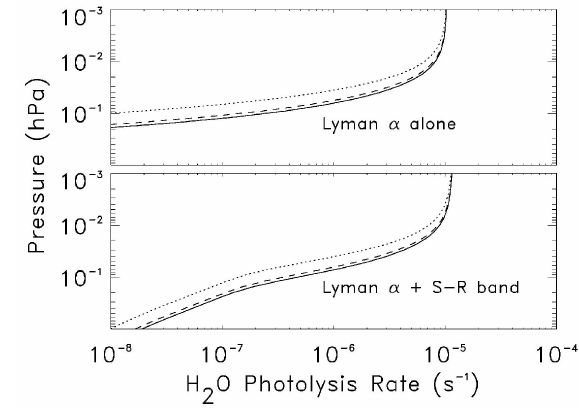
Fig. 5. Mean β from 2004–2008 MLS OH NH summer measure- ments (solid), along with derived values of β from ozone photodis- sociation (dashed) and water vapor dissociation (dotted), assuming a square-root dependence on HO x production as described in the text.